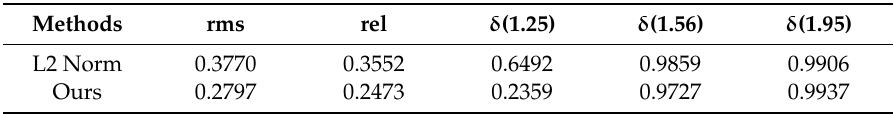
Table 1. Quantitative evaluation of our method in comparison to the reference method using the L2 norm. Lower is better for rms and rel and higher is better for δ